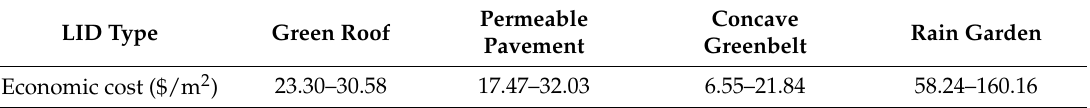
Table 6. Economic costs of typical LID measures.